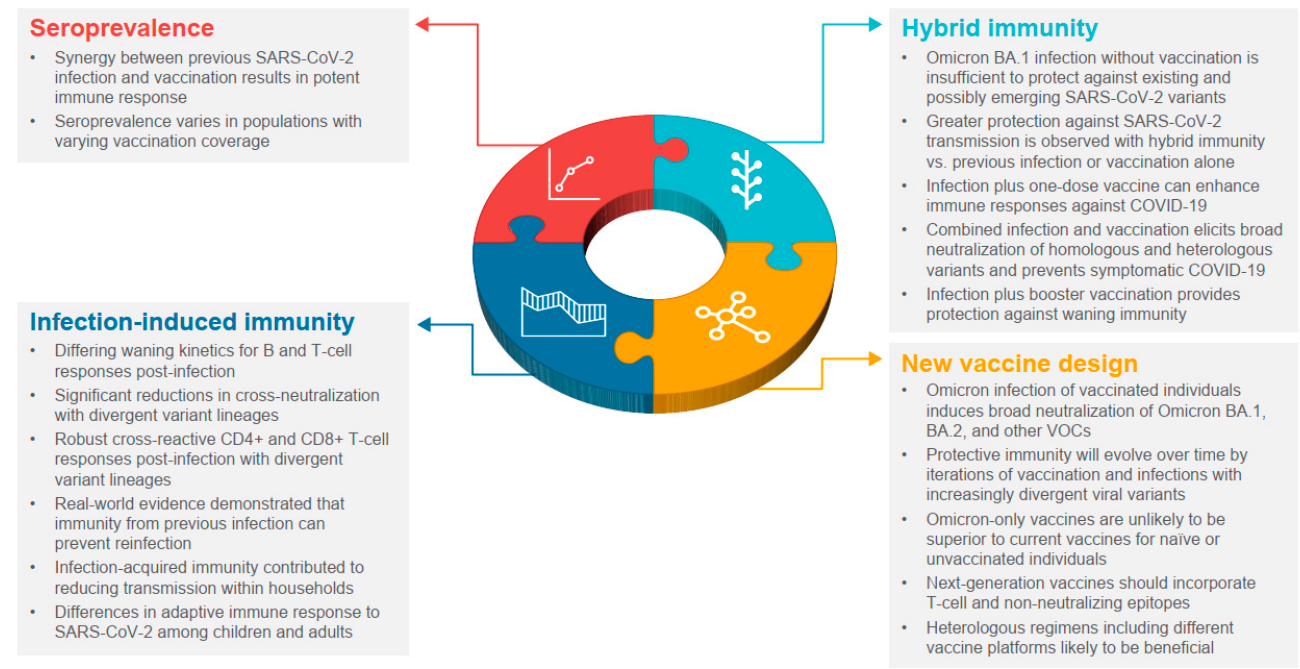
Figure 3. Lessons learned from widespread infection and vaccination. VOC, variants of concern.